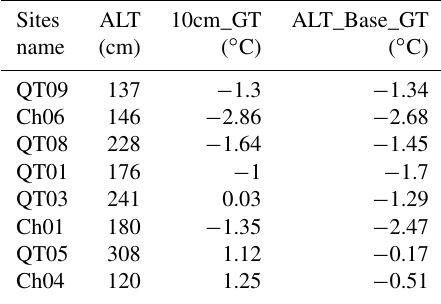
Table 3. The mean active layer thickness, ground temperature at a depth of 10cm, and permafrost